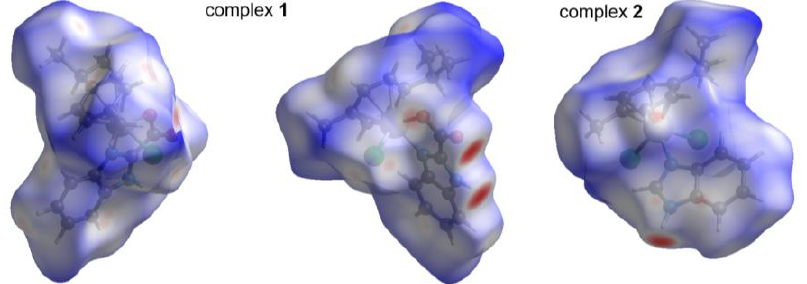
Figure 3. The Hirschfeld surfaces highlight the relevant d norm surface patches associated with the specific contacts for arene Ru(II) complexes.